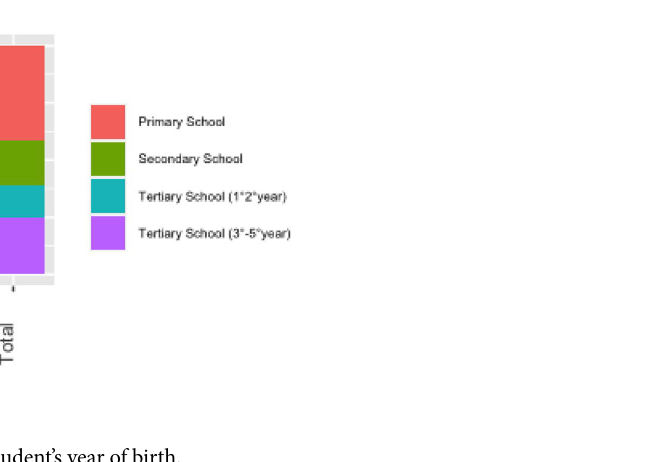
Figure 3. Time diagnosis and student’s year of